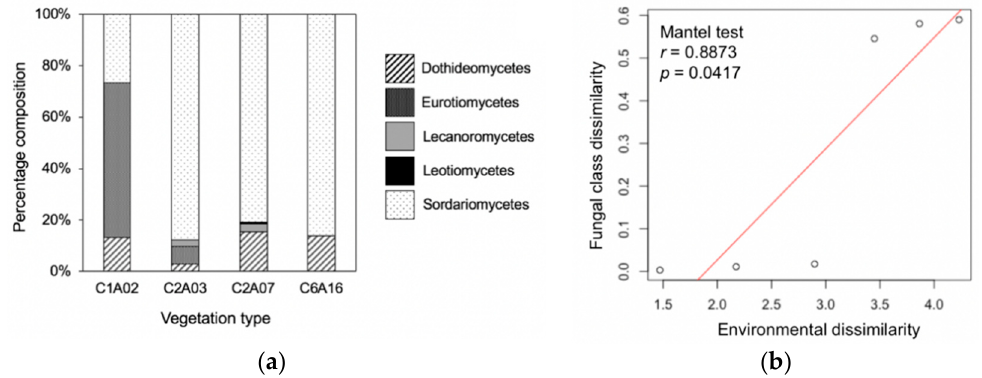
Figure 4. The class-level phylogenetic composition of endophytes differed among vegetation types. ( a ) Phylogenetic compositions of vegetation type. ( b ) The correlation of fungal class dissimilarity with environment. The fungal class dissimilarity (Morisita–Horn index) between vegetation types was significantly correlated with environmental dissimilarity.